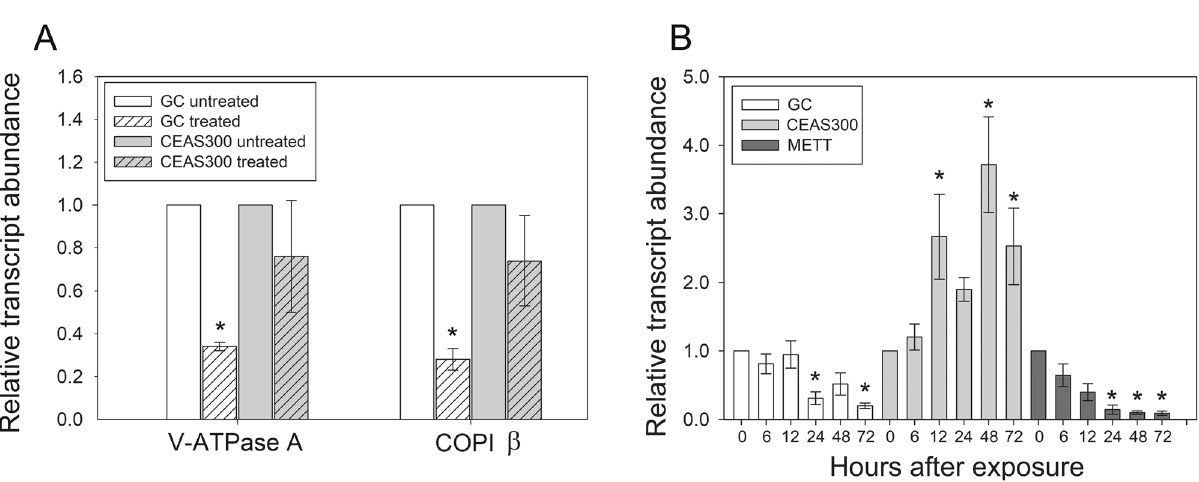
Figure 2. Change in target transcript abundance at different time points after feeding Leptinotarsa decemlineata larvae with potato leaves coated with dsRNA or a drop containing dsRNA. ( A ) Transcript abundance (relative to levels in larvae fed untreated potato leaves) in larvae from susceptible (GC) and dsRNA-resistant (CEAS 300) strains when fed potato leaves coated in a solution with 400 μg/ml of dsRNA targeting the V-ATPase subunit A transcript. Asterisks denote significant differences from untreated controls within each population (One Way Analysis of Variance followed by Holm-Sidak’s pairwise multiple comparisons test, P < 0.05). ( B ) Transcript abundance (relative to time 0 within each strain) when L. decemlineata larvae from susceptible (GC and METT) and dsRNA-resistant (CEAS 300) strains were treated with 25 μg of dsRNA targeting the V-ATPase subunit A transcript. Asterisks denote significant differences from time 0 (control) within each population (Kruskall- Wallis ANOVA on Ranks followed by a Dunnet’s pairwise multiple comparison to the control group, P < were no significant differences ( P = 0.918, Kruskal–Wallis One Way ANOVA on Ranks) in prepupal weights of CEAS 300 in control versus treated individuals at 9.41 μg/ml or even 300 μg/ml of V-ATPase A dsRNA (Fig. 1). Detection of RNAi gene silencing. After a chronic exposure for 48 h to potato leaves coated with 400 μg/ ml of dsRNA targeting the V-ATPase subunit A gene, larvae from the GC strain presented a significant ( P < 0.05, Holm-Sidak’s pairwise multiple comparisons test) reduction in the levels of V-ATPase subunit A transcript (2.9- fold) when compared to larvae fed non-treated leaves (Fig. 2A). In contrast, no significant differences ( P = 0.901, Holm-Sidak’s pairwise multiple comparisons test) in V-ATPase subunit A transcript levels were detected between control and treated larvae of the CEAS 300 strain (Fig. 2A). Acute exposure of larvae from the GC population to a single dose of dsRNA targeting the V-ATPase subunit A gene (25 μg fed in a drop) resulted in a significant reduction in transcript levels 24 h (3.2-fold) and 72 h (5.0-fold) post-treatment ( P < 0.05, Dunnett’s multiple comparison) (Fig. 2B). A two-fold reduction was also detected 48 h